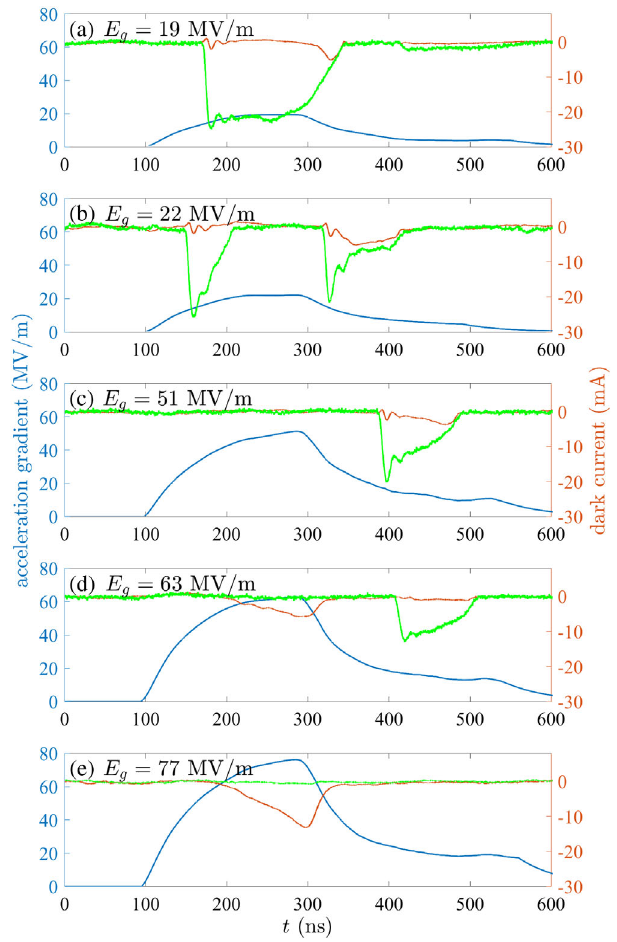
FIG. 12. Sample traces of the gradient (blue), side dark current (green) and downstream dark current (red) measurement results at the very initial stage of the E structure conditioning, for gradients of (a) 19 MV = m, (b) 22 MV = m, (c) 51 MV = m, (d) 63 MV = m and (e) 77 MV =